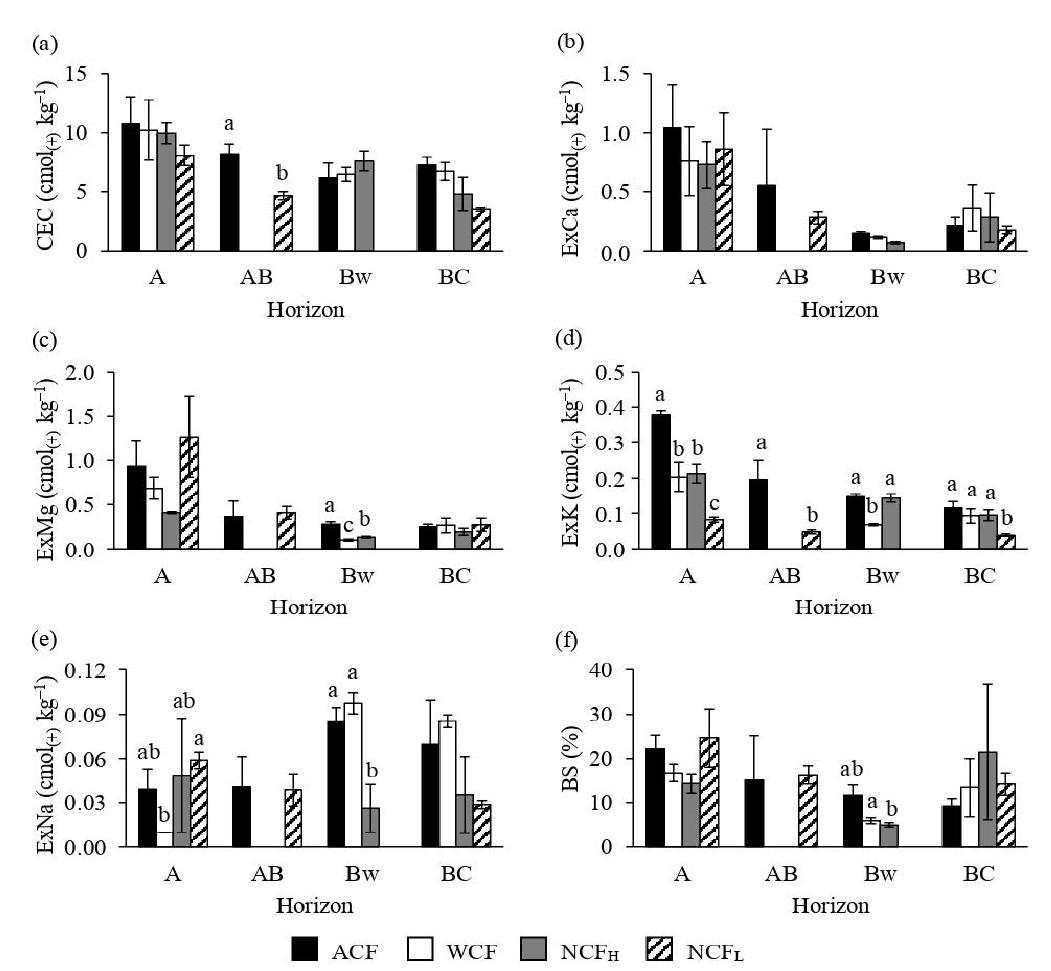
Figure 3. Cation exchange capacity (CEC; a ), concentrations of exchangeable calcium (ExCa; b ), exchangeable magnesium (ExMg; c ), exchangeable potassium (ExK; d ), exchangeable sodium (ExNa; e ) and base saturation (BS; f ) of soils under an abandoned chestnut forest (ACF), a chestnut forest for wood production with a tree density of 151 plants ha –1 (WCF), a chestnut forest for nut production with a tree density of 120 plants ha –1 (NCF H ) and a chestnut forest for nut production with a tree density of 98 plants ha –1 (NCF L ). Error bars are the standard errors. Within each horizon, different letters indicate significant differences by Tukey’s t- test p ≤ 0.05.